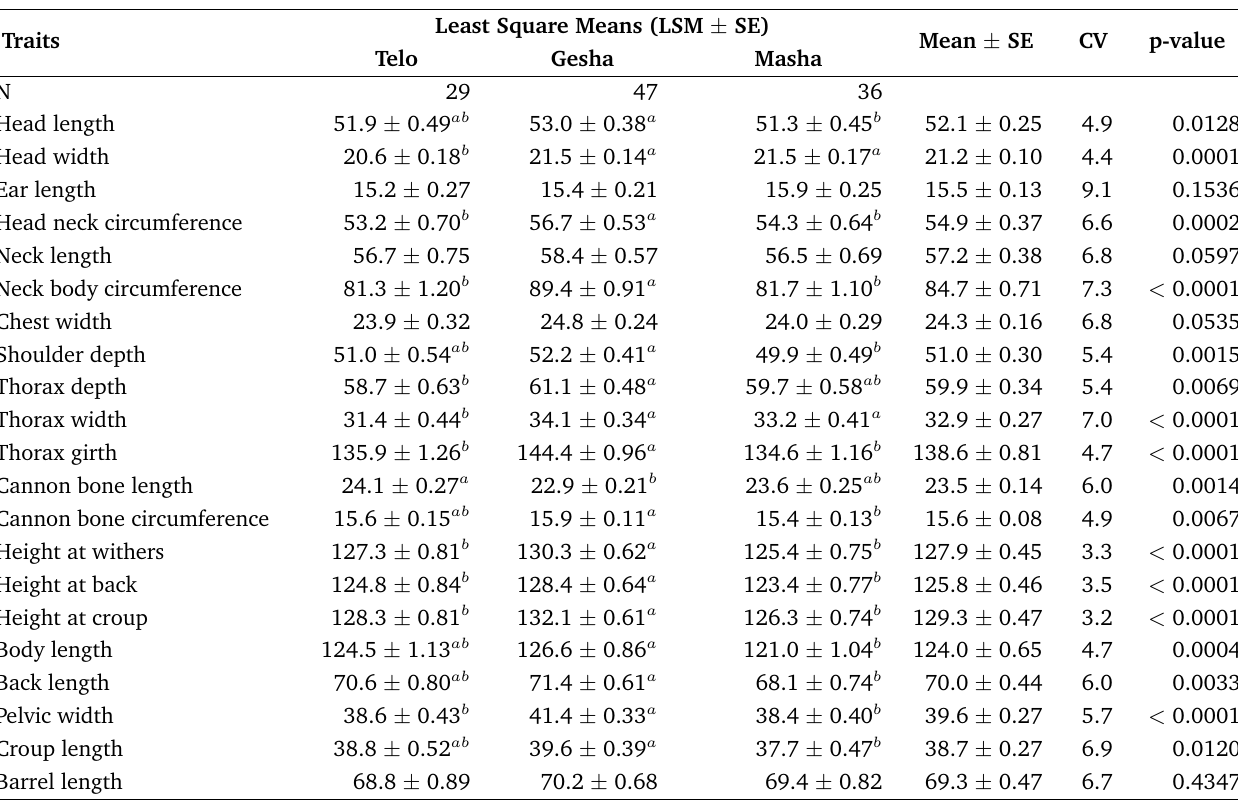
Table 5. Means and pairwise comparisons of morphometric measurements of the mares from different locations. Means within a row bearing different superscripts are significantly different; a indicates the largest value.